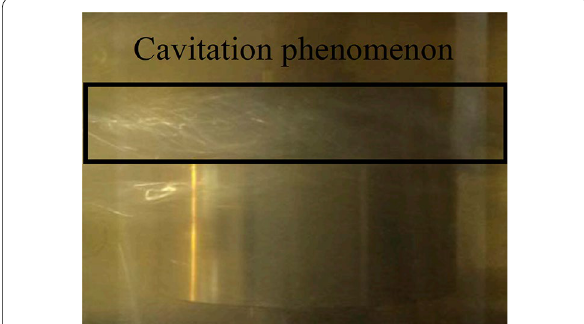
Figure 13 Cavitation in